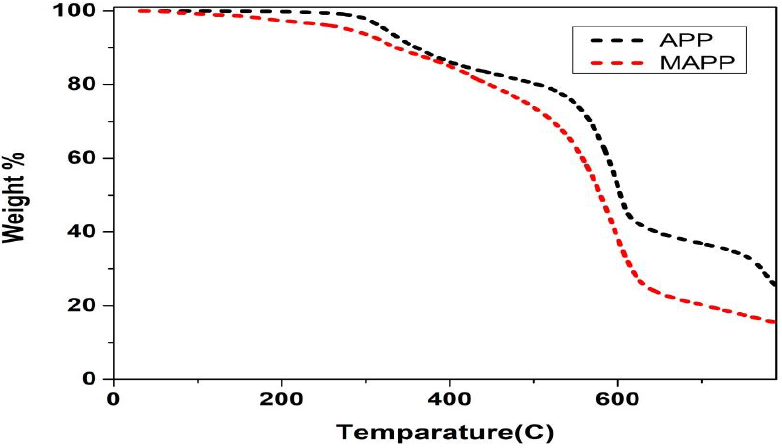
Figure 3. TGA curve of APP and MAPP.